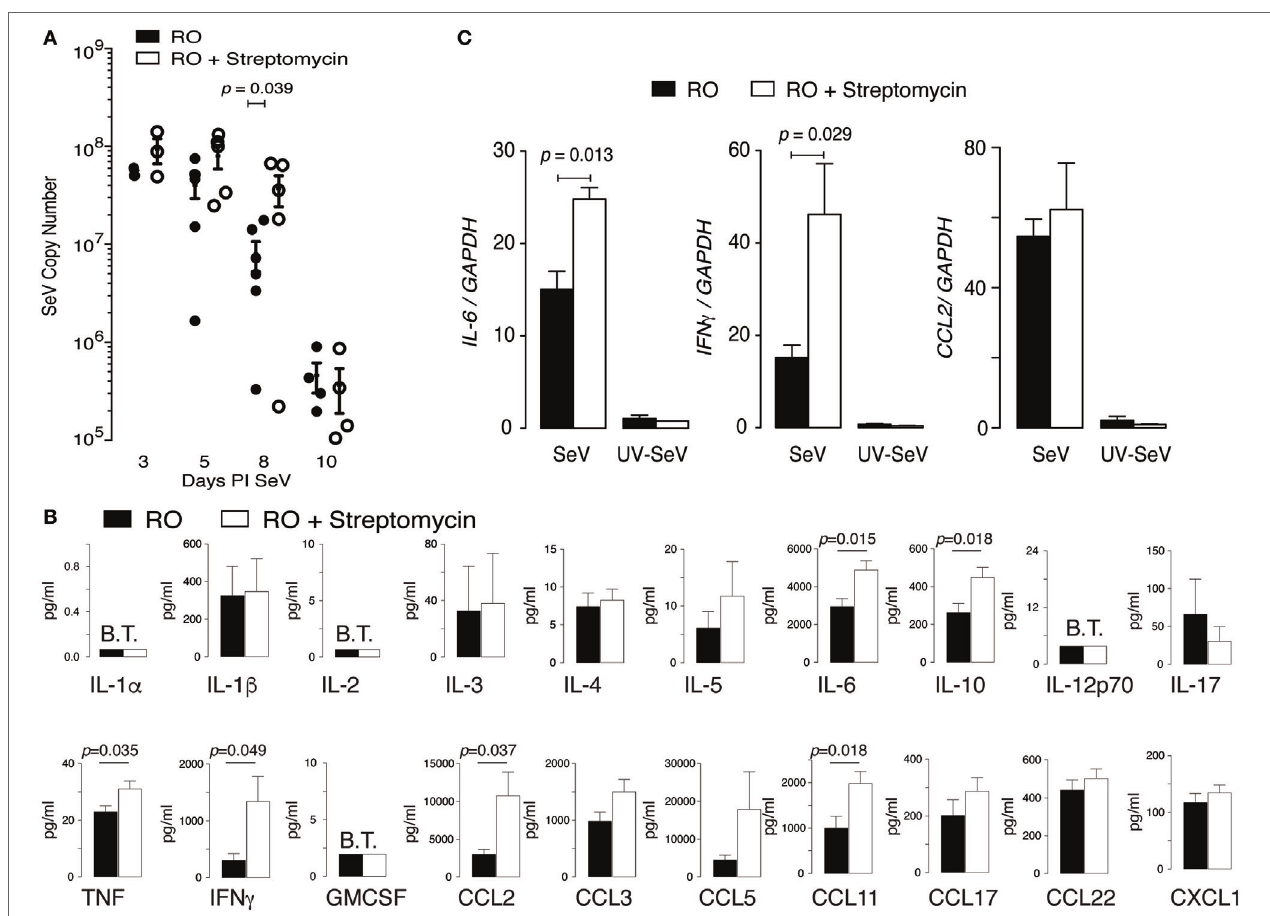
FigUre 4 | Altered intestinal microbiota augments pulmonary cytokine response to Sendai virus (SeV), but does not impair viral clearance. Mice were placed on reverse osmosis (RO) or RO + streptomycin water, and 2 weeks later inoculated with SeV. (a) RT polymerase chain reaction (PCR) quantification of SeV copy number in whole lungs at the indicated days post inoculation (PI) SeV ( n = 3–6 mice/day and group). (B) Expression of cytokines in the bronchoalveolar lavage fluid of mice 8 days PI SeV. Data are array results from a commercially available ELISA protein array (data combined from five separate experiments with n ≥ 2/group/ experiment, with samples run in duplicate); note increased IL-6, IFN γ , and CCL2 (MCP-1) protein. (c) Message for Il6 and Ifn γ , but not Ccl2 , was increased in whole lung of SeV-infected mice that had received streptomycin. Specific cytokine mRNA levels were assessed by RT PCR in whole of lung of mice at day 8 PI SeV or UV inactivated SeV ( n = 3/group and treatment) and normalized to Gapdh copy